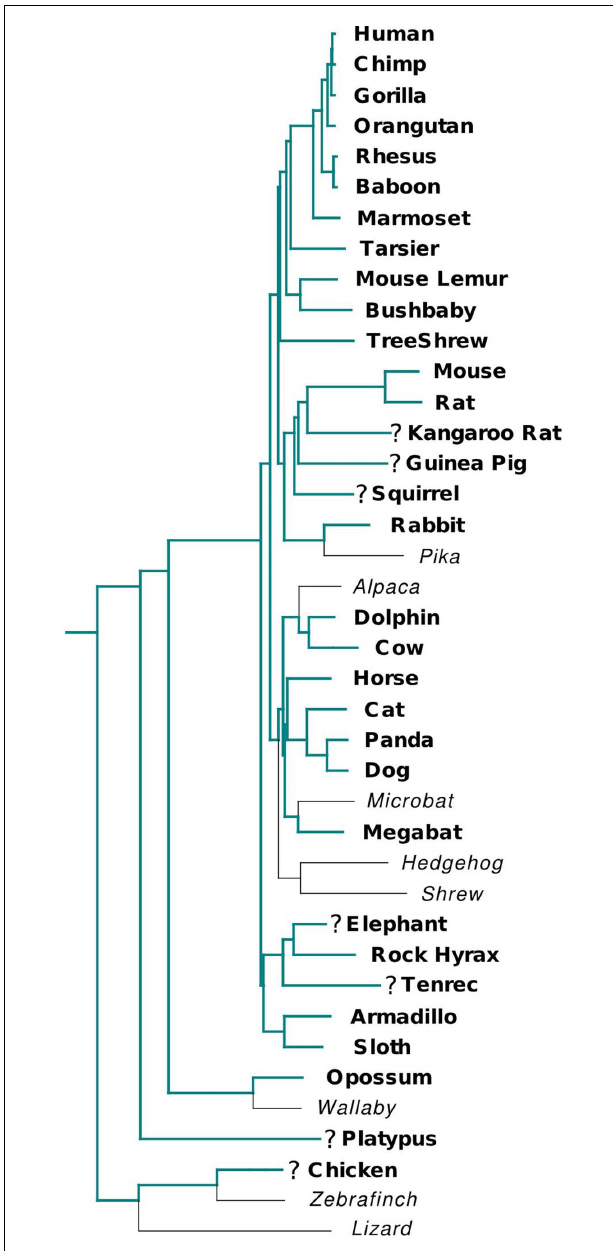
FIGURE 1 | Overview of eutherian EGO-B orthologs. Species in which a (nearly) complete EGO-B gene was found are highlighted. EGO-B candidates are labeled with question marks.The figure is based on the Ensembl species tree.